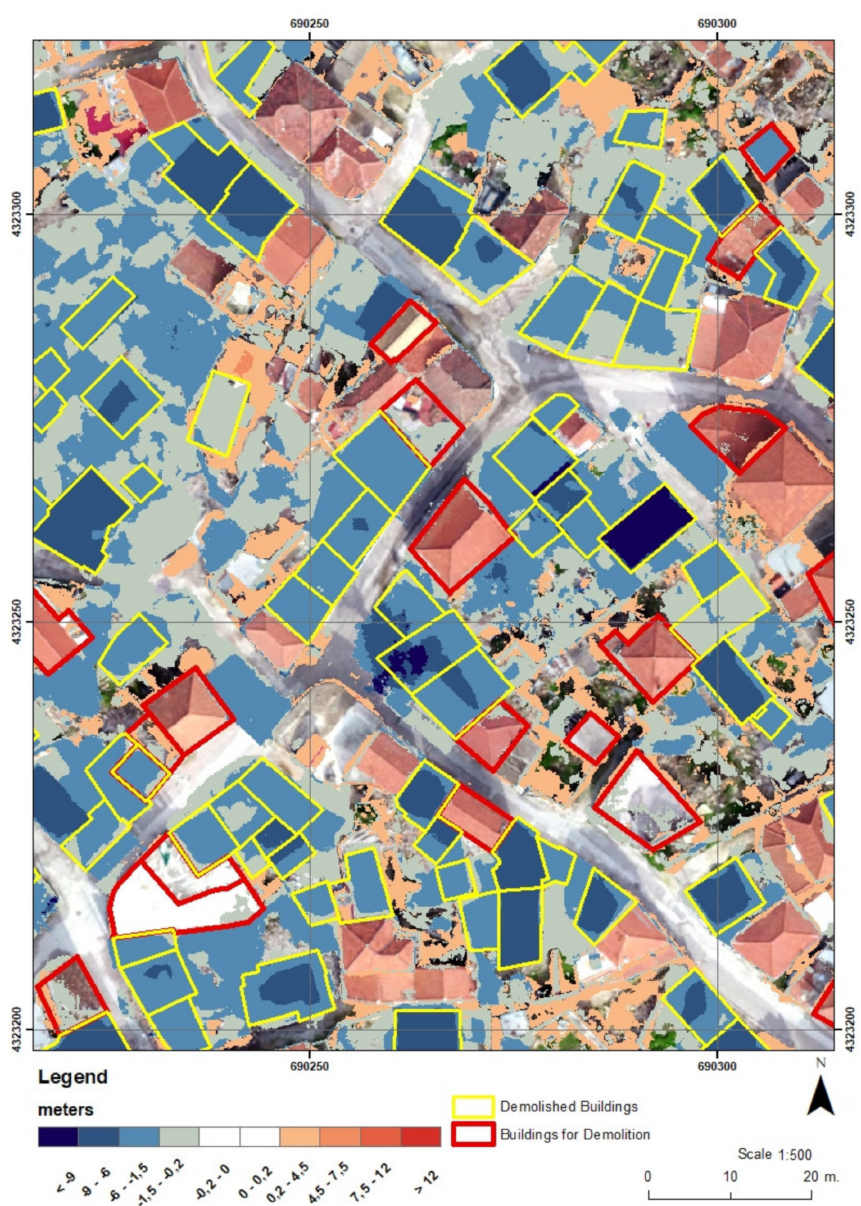
Figure 10. DSM of di ff erence map created by subtracting the DSM of 3rd February 2019 with the DSM of 25th July 2017. Blue colors on map present negative height values, which refer to the demolished buildings. Three map-classes (i) − 1.5 m to − 6 m, (ii) − 6 m to − 9 m, and (iii) < − 9 m, refer to one, two, and three-story buildings,